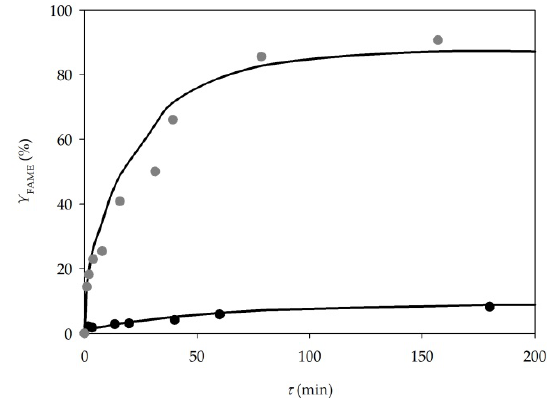
Figure 8. Validation of proposed mathematical model for lipase catalysed transesterification in a PTFE microreactor for different inlet methanol concen trations; 403. 6 mg/L ( ● ) , 40. 36 mg/L ( ● ), model ( ).